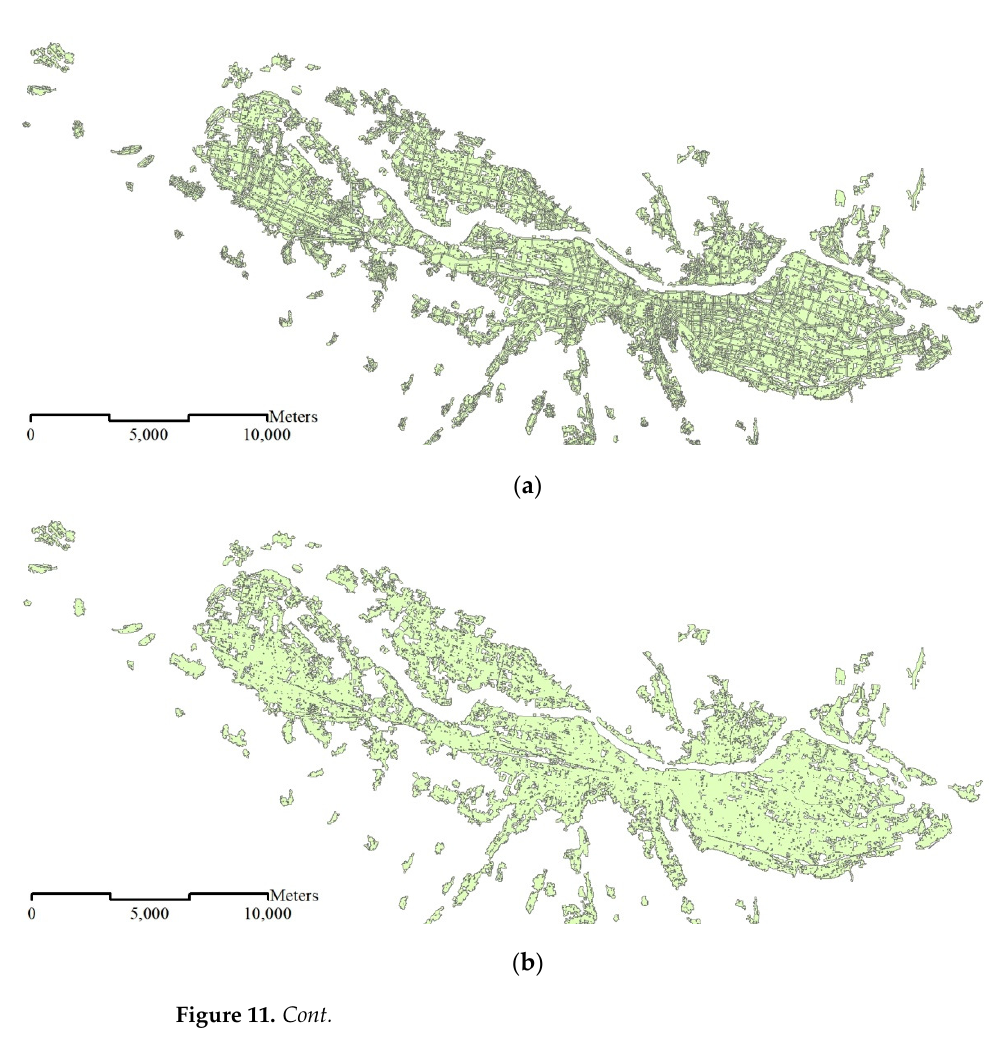
Figure 10. Buffering results (20 m) of 1:10K buildings.